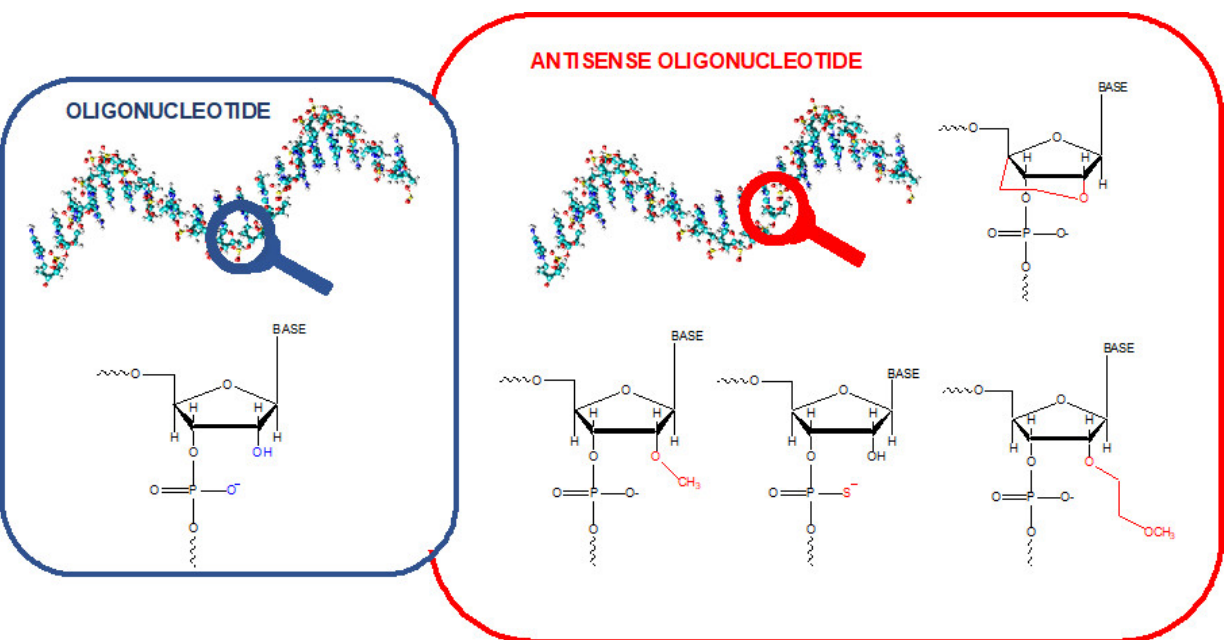
Figure 1. Schematic representation of the difference between the unmodified oligonucleotide and some antisense oligonucleotides.